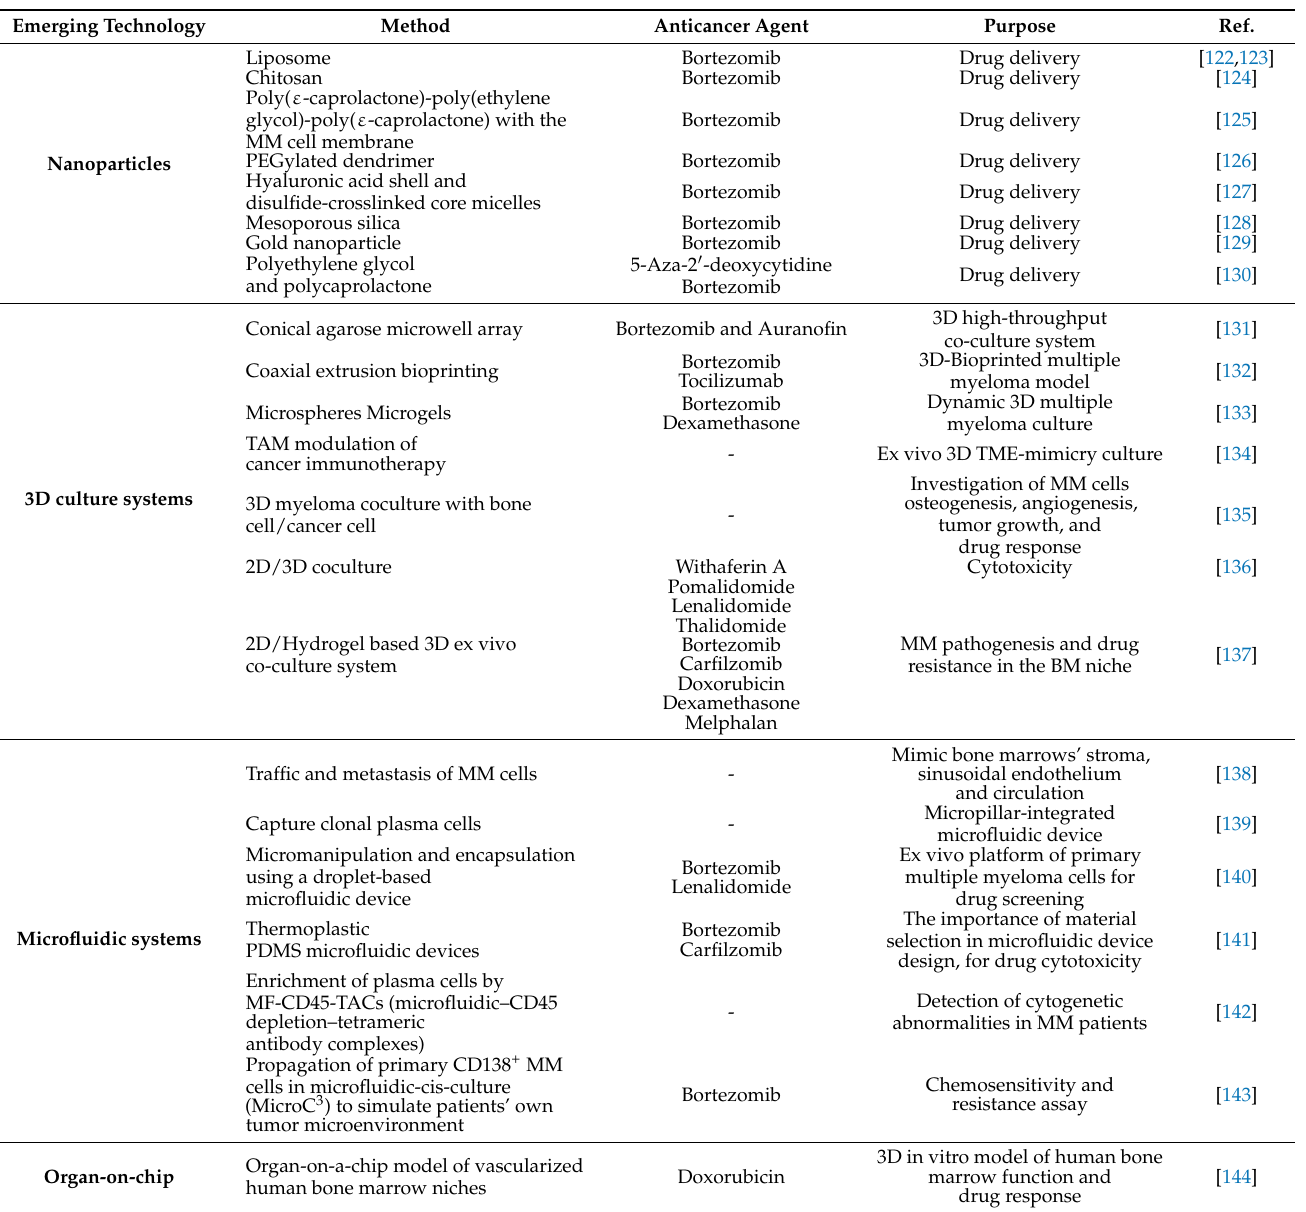
Table 3. Emerging technologies used in MM